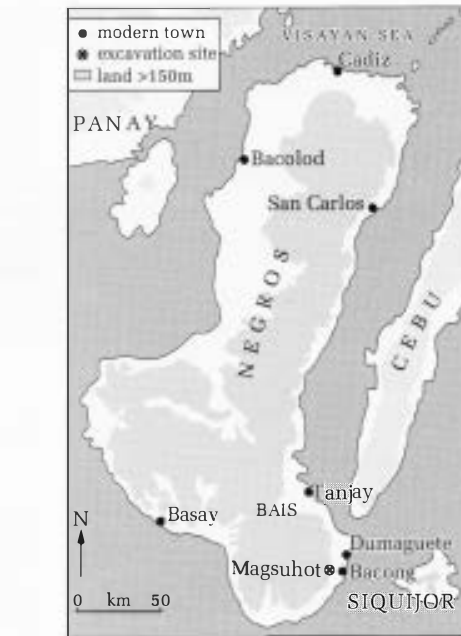
Figure 3 Negros and adjacent islands, showing the location of the Dumaguete­ Bacong archaeological project.